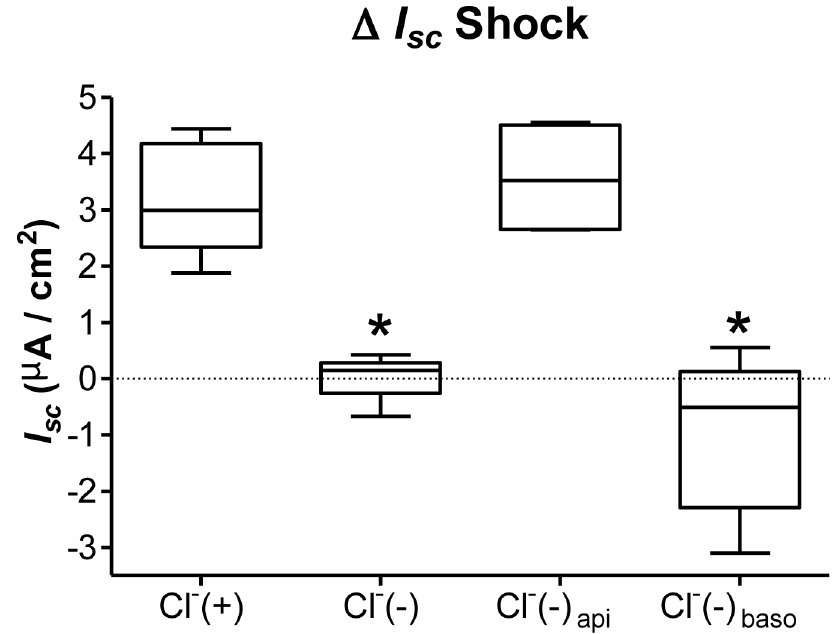
Figure 6. Impact of apical or basolateral Cl - (-) gradients on the current rise elicited by 20% hypotonic shock. The current rise elicited by hypotonic shock (Δ I Shock) was tested in the basal condition (Cl - (+)), with bilateral exposure to a buffer of reduced sc Cl - concentration (9 mM NaCl; 150 mM Na gluconate) (Cl - (-)), or by adding this buffer at the apical side (Cl - (-) api) or basolateral side (Cl - (-) baso) only. N≥4, *p<0.05 by Mann-Whitney Test compared to Cl -